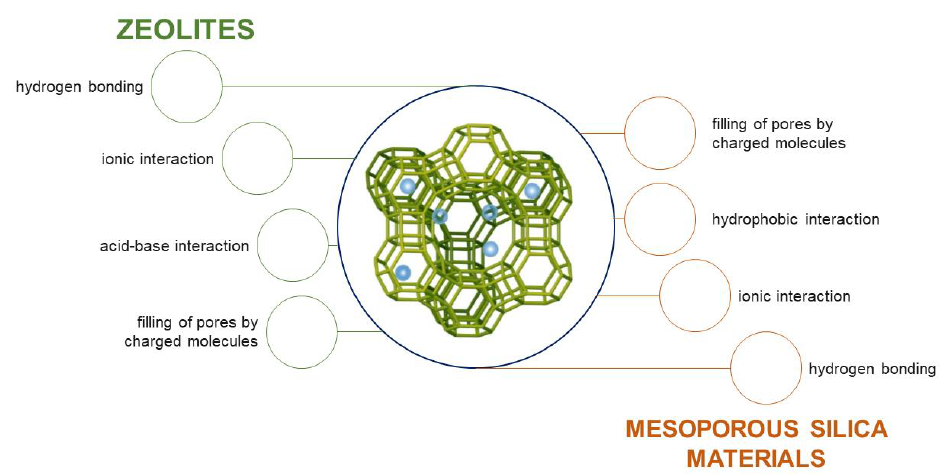
Figure 9. Mechanisms of pesticides immobilization onto modified and unmodified zeolites and mesoporous silica materials.